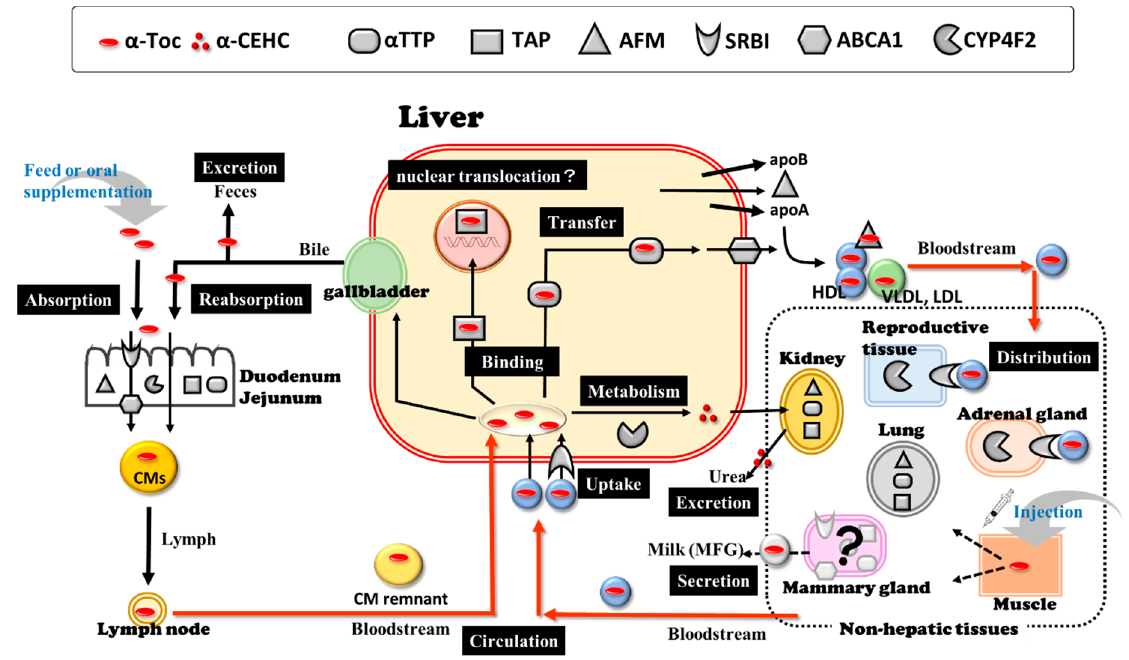
Figure 1. The possible mechanism of α -Toc disposition (metabolism, transportation, and tissue distribution) with the expression of α -Toc-related genes in cattle. Abbreviations: α -Toc, α -tocopherol; α -CEHC, α -carboxyethyl hydroxychromans; α TTP, α -tocopherol transfer protein; TAP, tocopherol associated protein; AFM, afamin; SRBI, scavenger receptor class B, Type I; ABCA1, ATP-binding cassette transporter A1; CYP4F2, cytochrome P450 family 4, subfamily F, polypeptide 2; CM, chylomicron; HDL, high density lipoprotein; VLDL, very low-density lipoprotein; LDL, low density lipoprotein; MFG, milk fat globules.